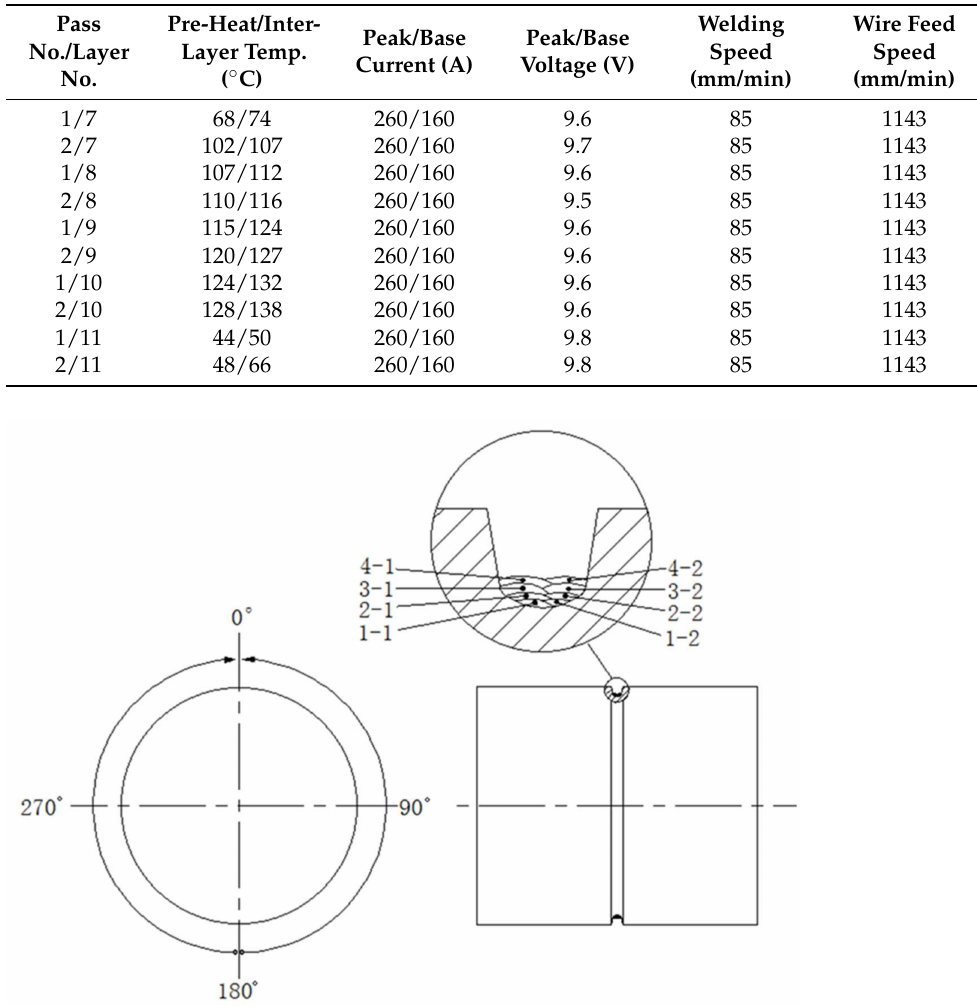
Figure 2. Schematic diagrams of welding directions ( left ) and welding layers and passes ( right